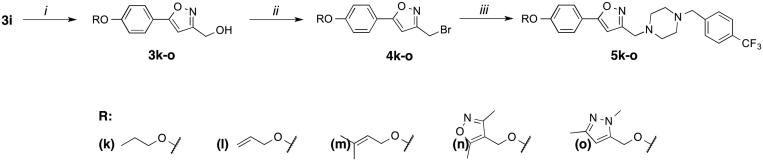
Synthesis of compounds 5k-o. Reagents and conditions: i. R-Br, K2CO3ii. CBr4/PPh3, DCM iii. 4- (trifluoromethyl)benzylpiperazine, DIEA, DMF.